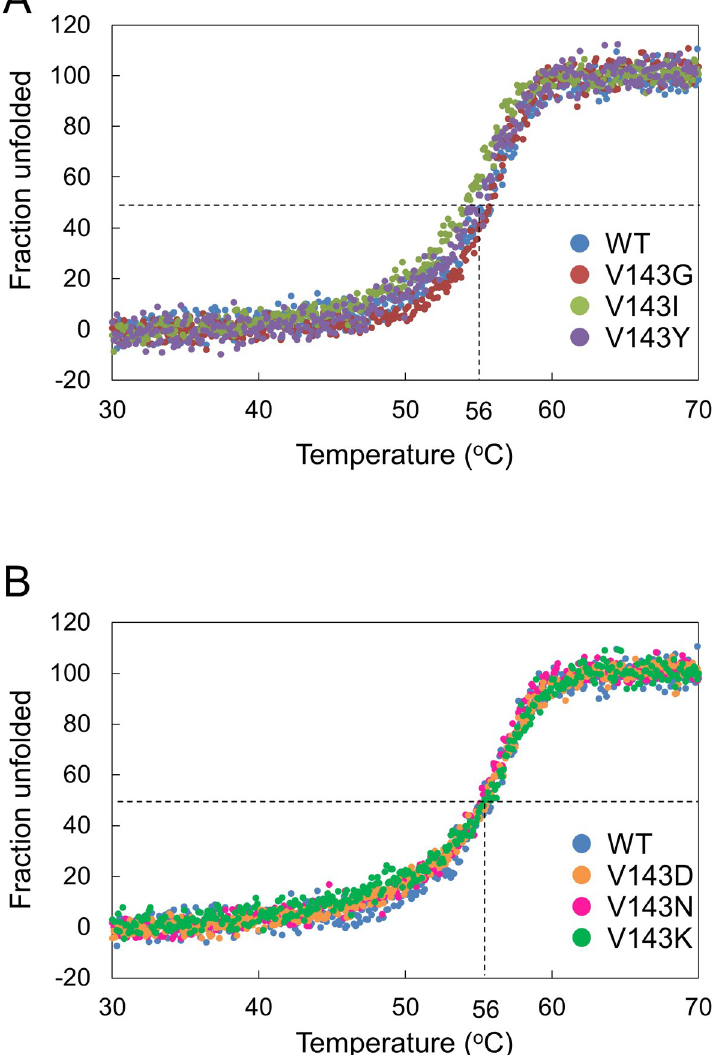
Fig 8. Thermal denaturation of Val143 variants. θ 222 of WT and variants were monitored from 30 to 70˚C at 1˚C/ min. The original data are in S5 Table.